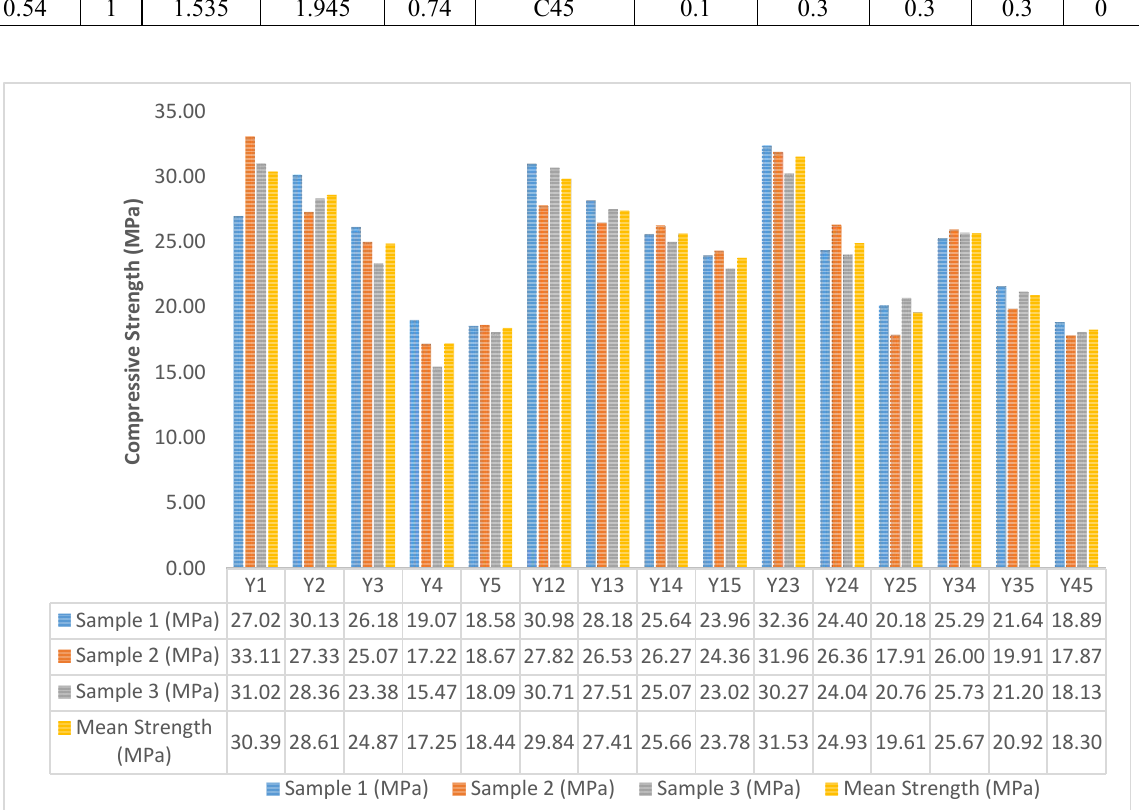
Fig. 2. The Compressive Strength (Laboratory Response,